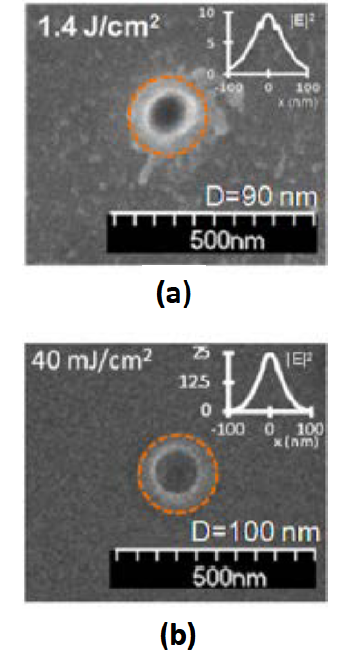
Figure 6: SEM images of nanoholes created on SiO 2 and Si sub- strates by single pulse irradiation from a 400-nm wavelength femtosecond laser using 200-nm diameter nanospheres of amor- phous TiO 2 . The dashed line shows the delineation of the applied nanospheres [51]. Reproduced with permission from The American Institute of Physics, © 2010 by The American Institute of